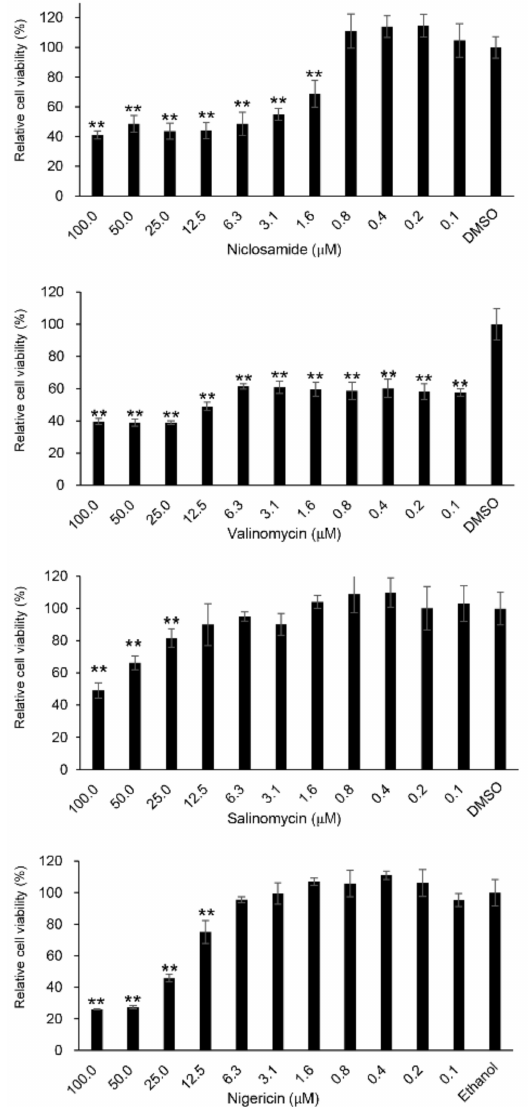
Figure 1. Cell viabilities with ionophore antibiotics. The Felis catus whole fetus-4 (Fcwf-4) cells were incubated with different types of ionophore antibiotics and niclosamide at various concentrations or a solvent (1% DMSO for niclosamide, valinomycin, and salinomycin, or 0.1% ethanol for nigericin) to examine cell toxicity. After 24 h treatment, cell viability was assessed by the WST-8 assay as described in the Materials and Methods section. Error bars indicate standard deviations (SD). Data were analyzed with one-way ANOVA with Dunnett’s multiple comparison test (** p < 0.001). Each graph column represents mean ± SD (N =